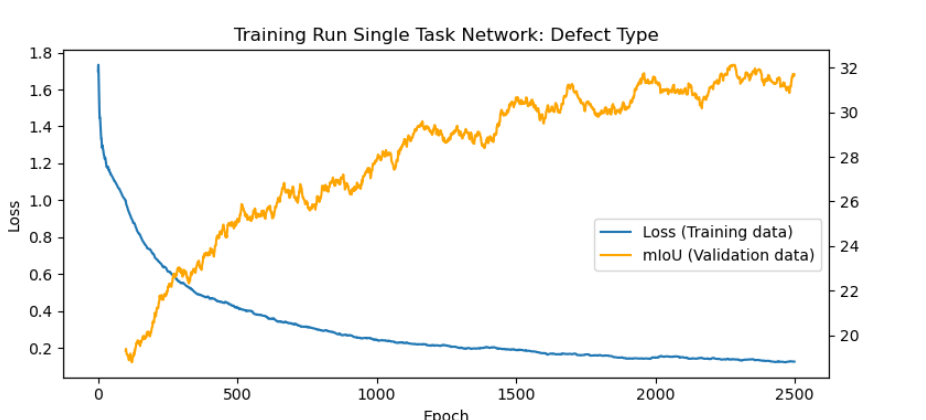
Figure 7. Training curve for the single-task defect type model. The chart shows both the loss curve on the training set and the mIoU score on the validation set for each epoch. The model with the highest mIoU validation score is chosen as the best